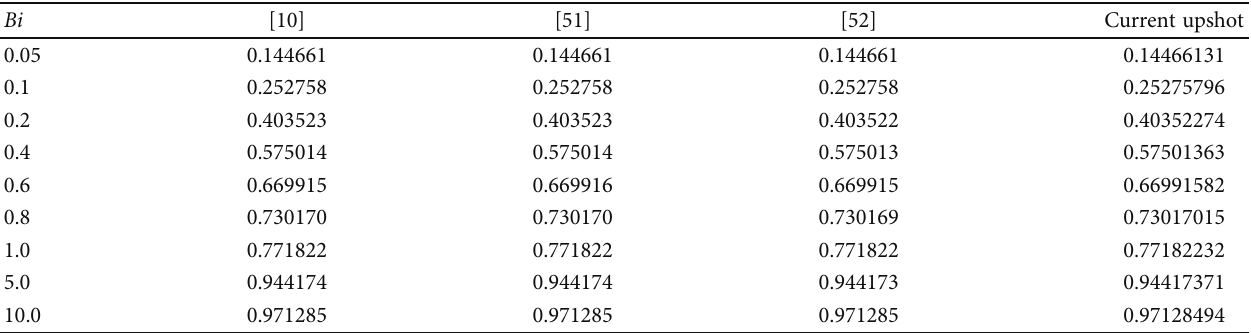
Table 3: Con fi rmation results of − θ ð 0 Þ for the values of the Biot number Bi with Pr = 0 : 72, Nb = Sc = 1 , and values of the rest parameter